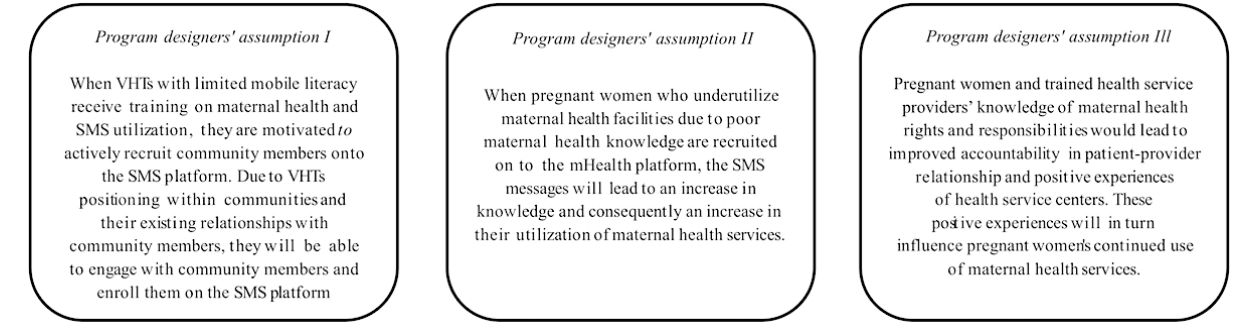
Figure 1. Program theory. SMS: short message service; VHTs: village health teams.